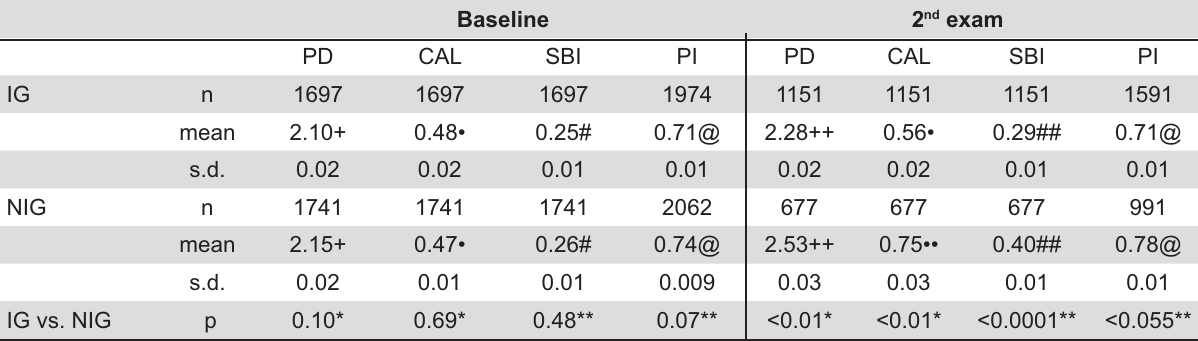
Table 2- Clinical periodontal parameters of IG (intervention) and NIG (no intervention) at baseline and second